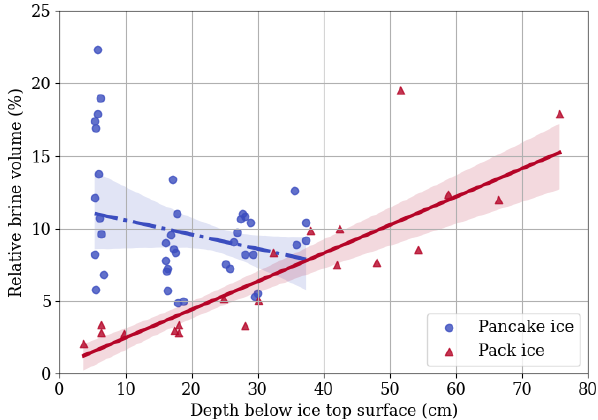
Figure 8. Brine volume as a percentage of the total volume as a function of depth for pancake ice floes and consolidated pack ice at stations MIZ1D and MIZ3A, respectively. The shading indicates the 90th-percentile confidence intervals.